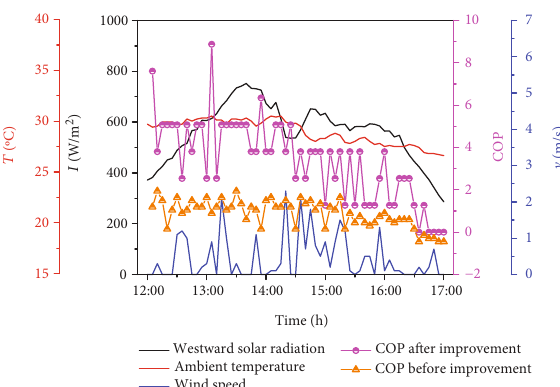
Figure 11: The comparison curves of heating COP under similar conditions.